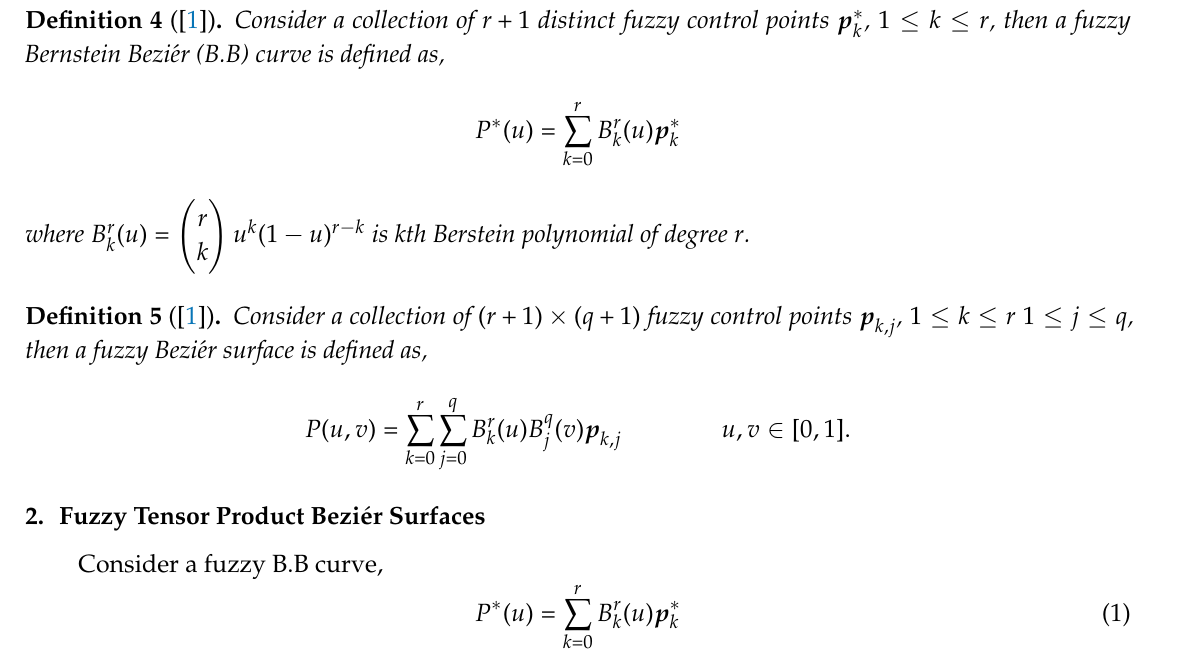
Table 1, is shown in Figure 1. The fuzzy control points along with dashed lines is called a fuzzy control grid of a fuzzy surface. Each column and row of the fuzzy control points interpret a fuzzy B.B curve. The fuzzy B.B curve defined by the fuzzy control points p , 0 ≤ j ≤ q is called k th fuzzy u -curve k , j and the fuzzy B.B curve defined by p , 0 ≤ k ≤ r is j th fuzzy v -curve. Consequently, there are ( r + 1) k , j number of fuzzy u -curves and ( q + 1) number of fuzzy v -curves. The fuzzy u -curves of Figure 1 are shown in Figure 2. The fuzzy u -curve with 0th row of fuzzy control points is shown with red lines, the 1st row of fuzzy control points is shown in blue and the 2nd row of fuzzy control points is shown in